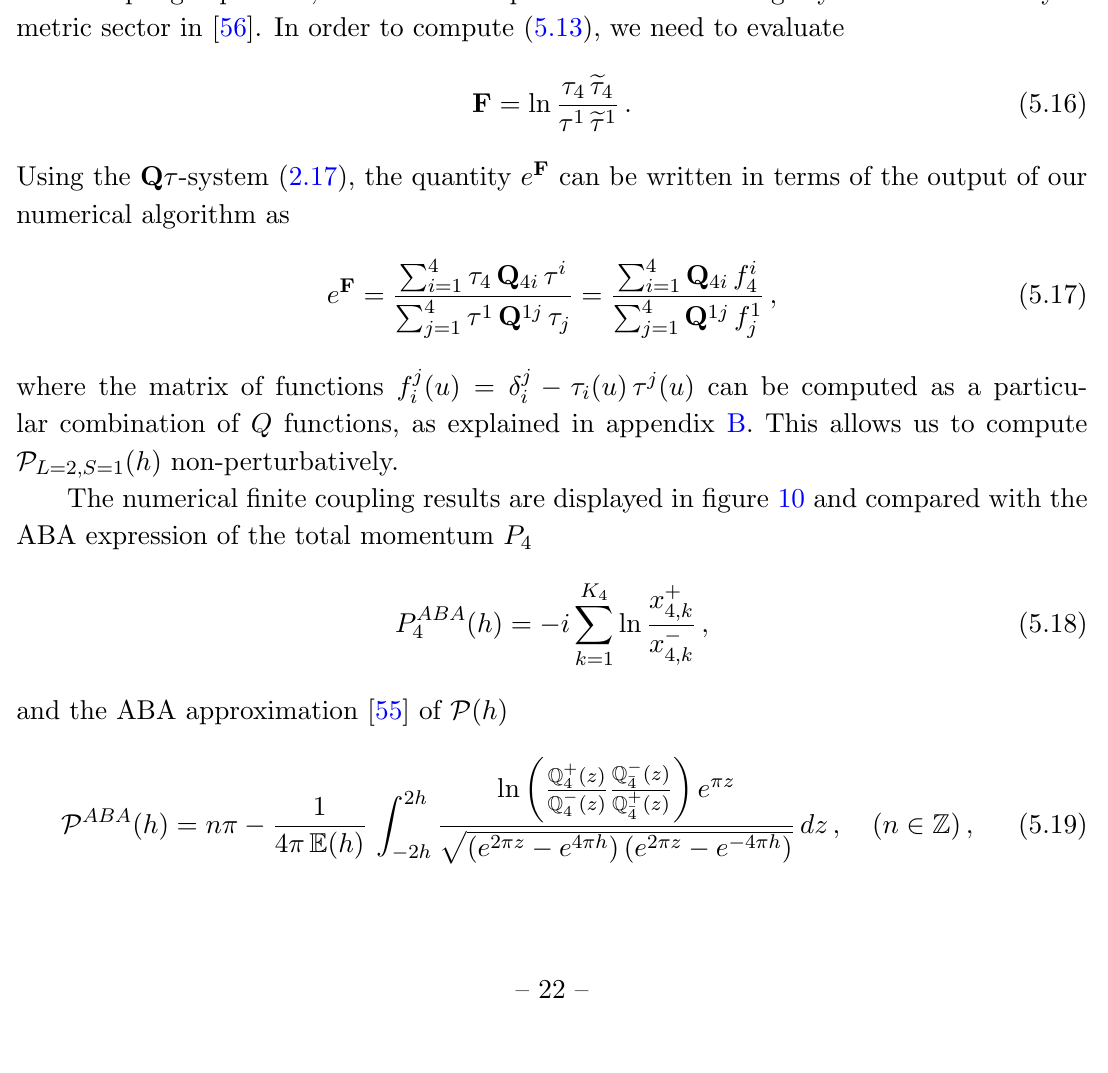
( h ) and the dashed line represents P ABA L =2 ;S =1